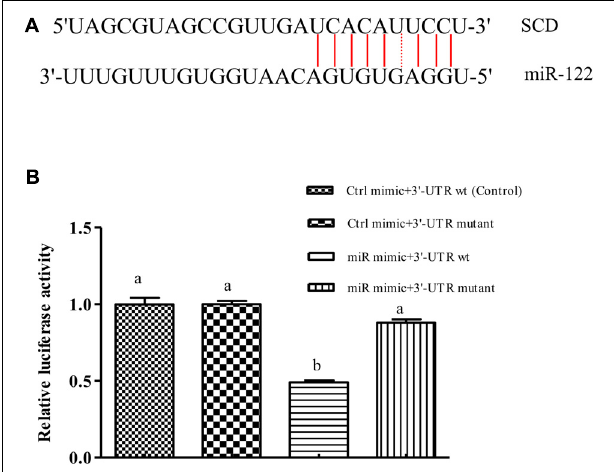
FIGURE 1 | miR-122 regulates SCD expression by binding with 6-nucleotide sequence in SCD 3 (cid:48) -UTR. (A) Sequence complementarity between miR-122 and SCD 3’-UTR. (B) Dual luciferase reporter assay system used to test binding between miR-122 and SCD in HEK293T cells. Ctrl mimic, 3 (cid:48) -UTR wt, 3 (cid:48) -UTR mutant, and miR mimic are also referred to as miRNA negative control, SCD-WT, SCD-Mut, and miR-122 mimic, respectively. Different lowercase letters show significant differences among treatments at each sampling point ( P < 0.05, Duncan’s multiple range